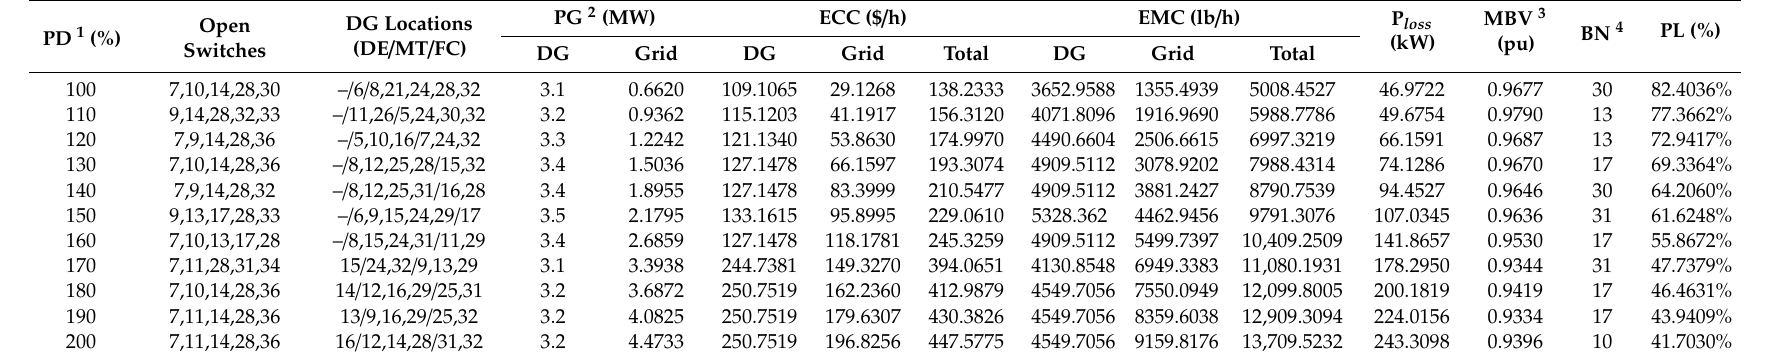
Table 12. Scenario 2: system reconfiguration results of auto-select DG combination under 6 DGs and increasing power demand.